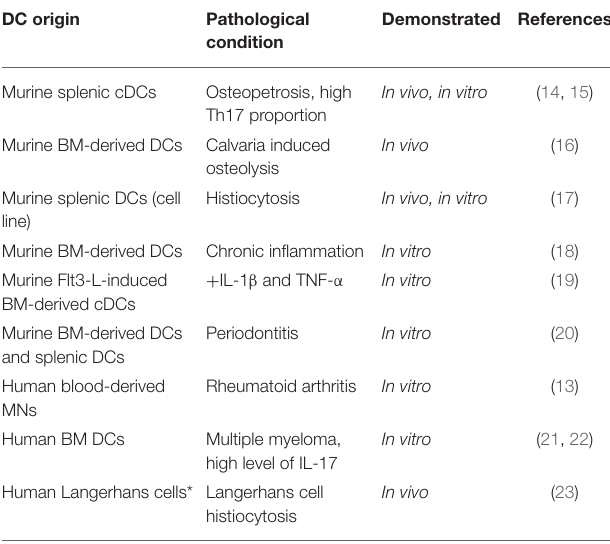
TABLE 1 | Pathological conditions associated with inflammatory osteoclasts differentiated from dendritic